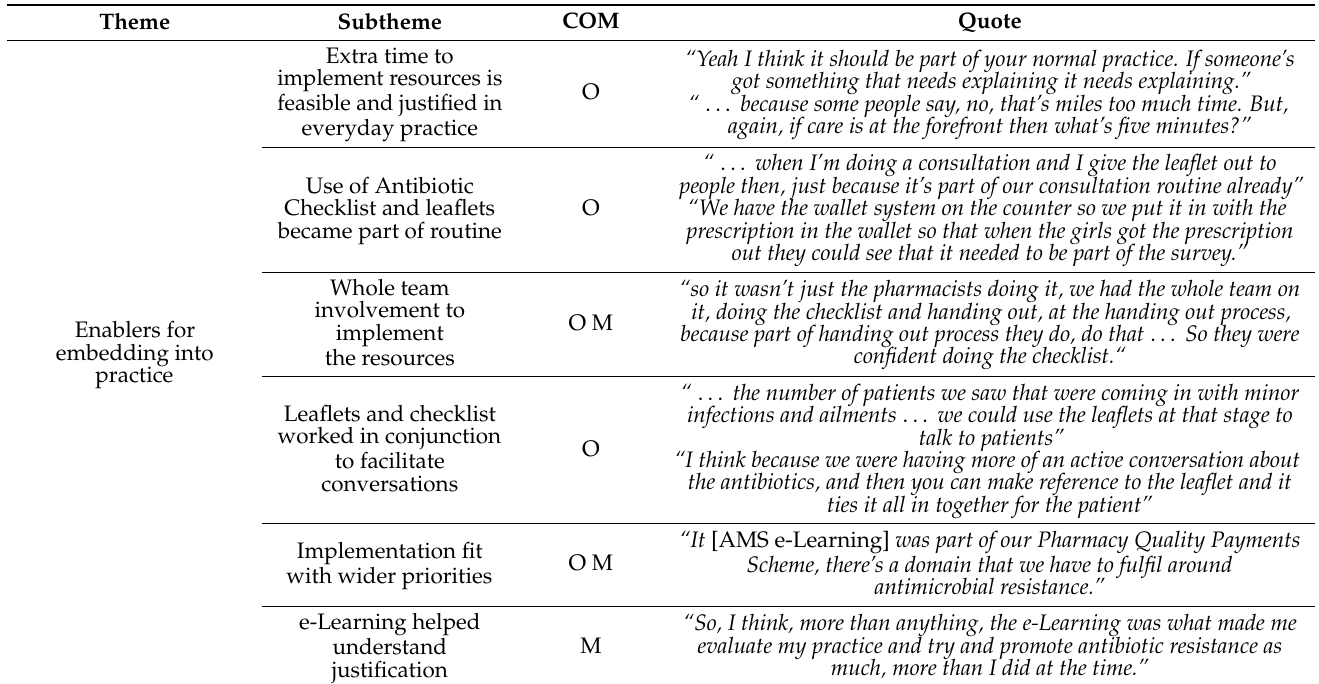
Table 2. Staff themes and subthemes on facilitators and barriers to implementing the PAMSI. Mapped to Capability (C), Opportunity (O), Motivation (M)